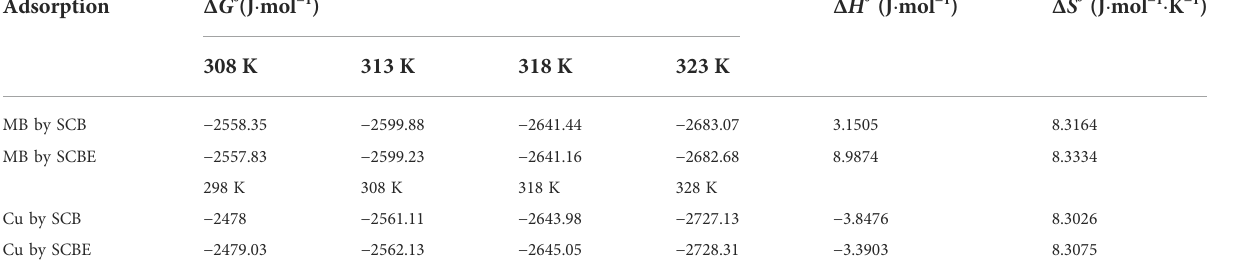
TABLE 4 Thermodynamic parameters for MB dye and Cu 2+ adsorption by SCB or SCBE.